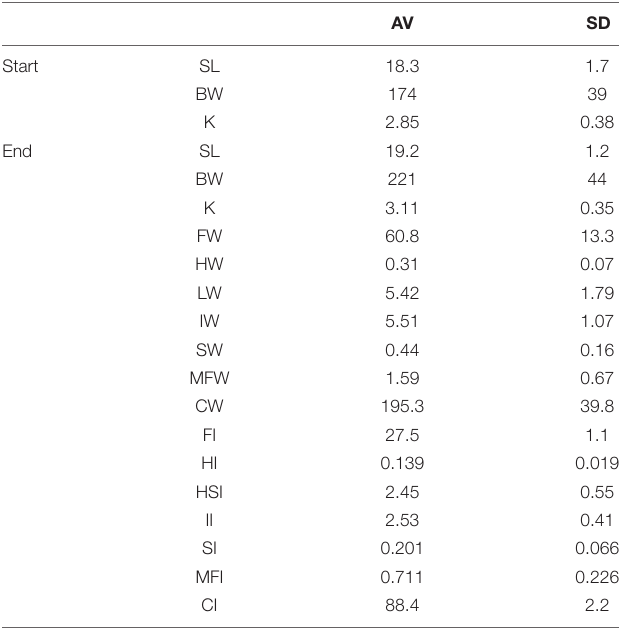
TABLE 1 | Biometry, tissue weights, and indices of tagged fish at the start ( N = 30) and at the end of the 6 weeks sea-cage period ( N = 27).